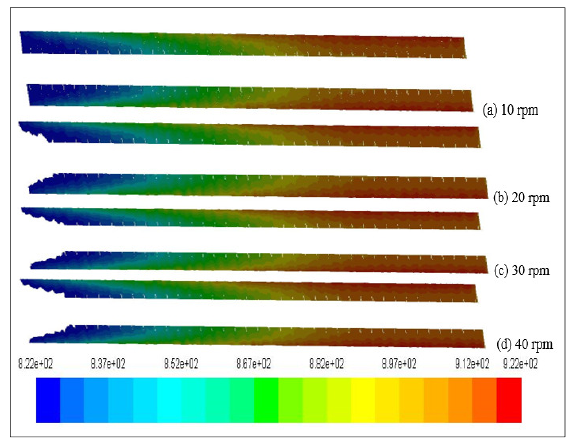
Fig. 8. Specific heat Contour plane at 250 gm.